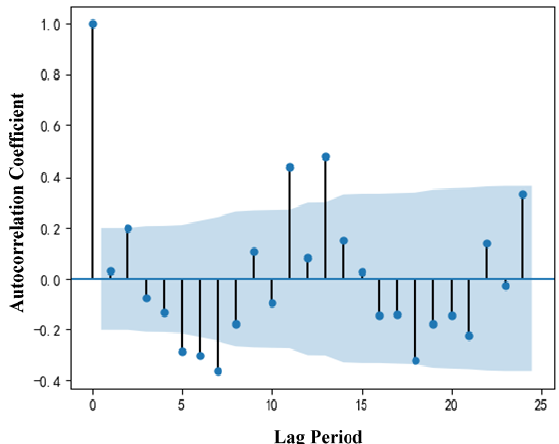
Figure 10. Offset azimuth ACF analysis.